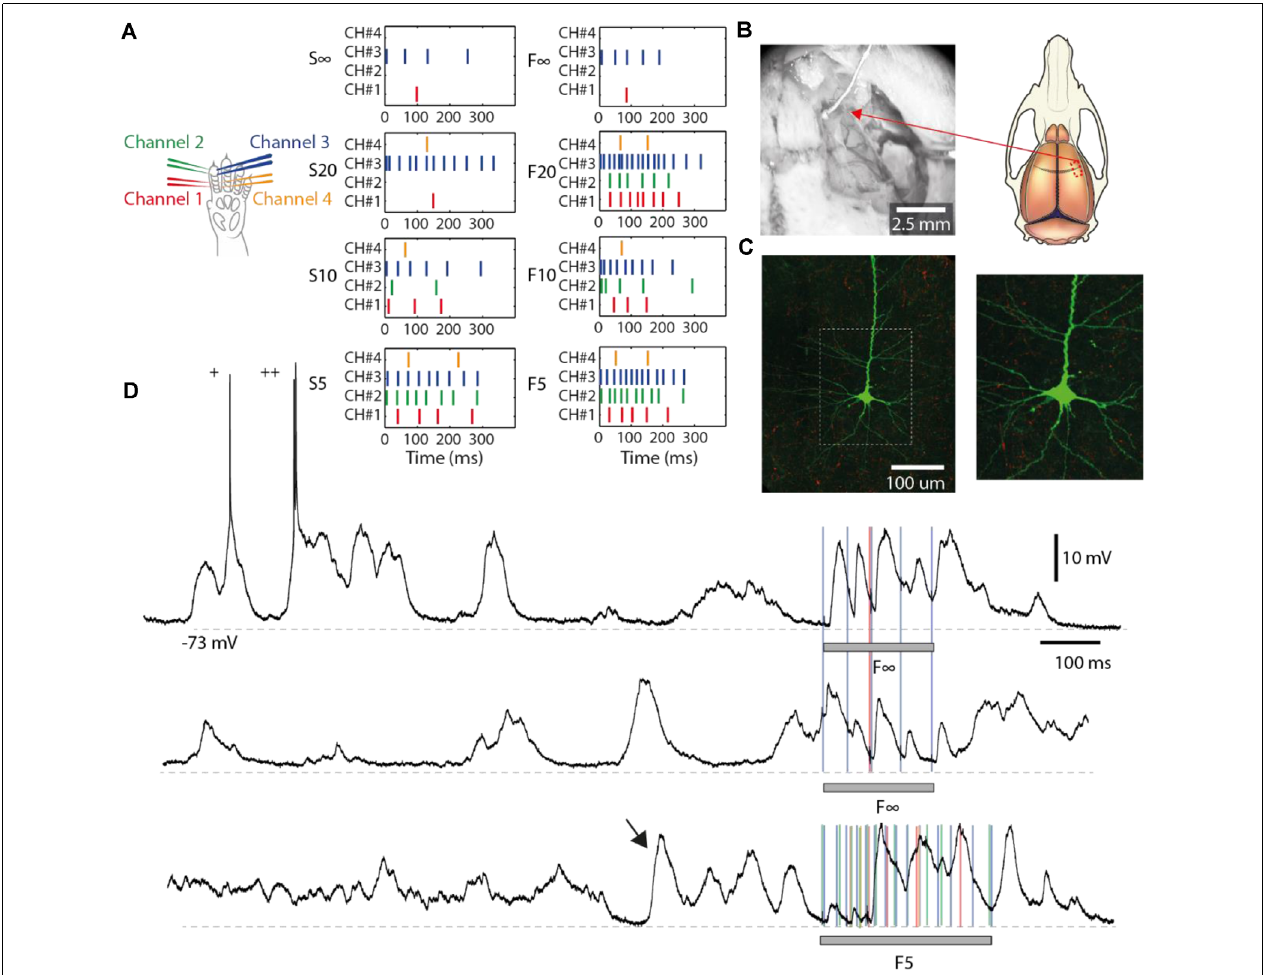
FIGURE 1 | Electrical skin stimulation and general properties of the intracellular responses. (A) Locations of the four pairs of intracutaneous needle electrodes (“channels”) inserted in digit 2 to stimulate the tactile primary afferents. The eight spatiotemporal patterns were re-used from a previous publication (Oddo et al., 2017). (B) Left: neuronal recordings were made in an exposed cortical area of 4 by 2 mm, located in the center of the photo. An electrocorticography (ECoG) surface electrode was placed on the brain. Right: a schematic illustrating the location of the exposed cortical area (red, dashed rectangle). (C) Left: a stained layer III pyramidal neuron from one of the recordings. The white dashed rectangle represents the zoomed-in area shown to the right. (D) Intracellular traces illustrating the spontaneous activity and responses evoked by the stimulation patterns (gray horizontal bars). “ + ” indicates occasional spikes. The arrow indicates a spontaneous activity pattern resembling an evoked response. Colored lines indicate the times of individual stimulation pulses in pattern F(inf) and F5, respectively. Recording from Neuron #7. Stimulus artifacts are truncated for